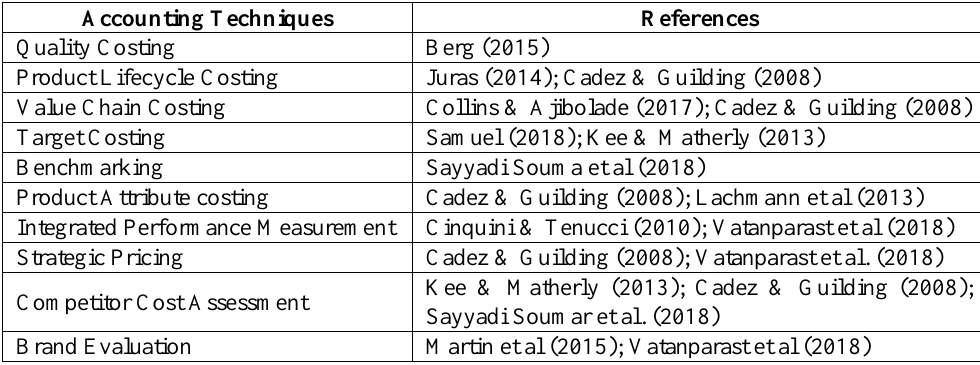
Table 1. Determination of strategic management accounting techniques based on